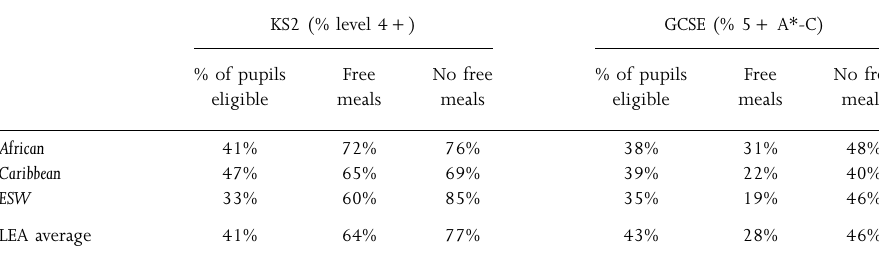
Table 3 Performance by key stage, free school meals and ethnic background in Lambeth 2002 KS2 (% level